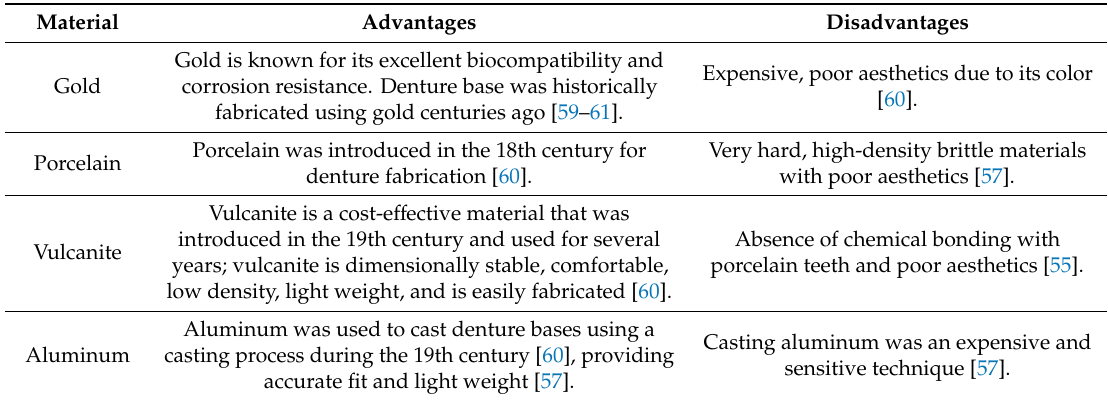
Table 2. Key advantages and disadvantages of various denture base materials replaced by